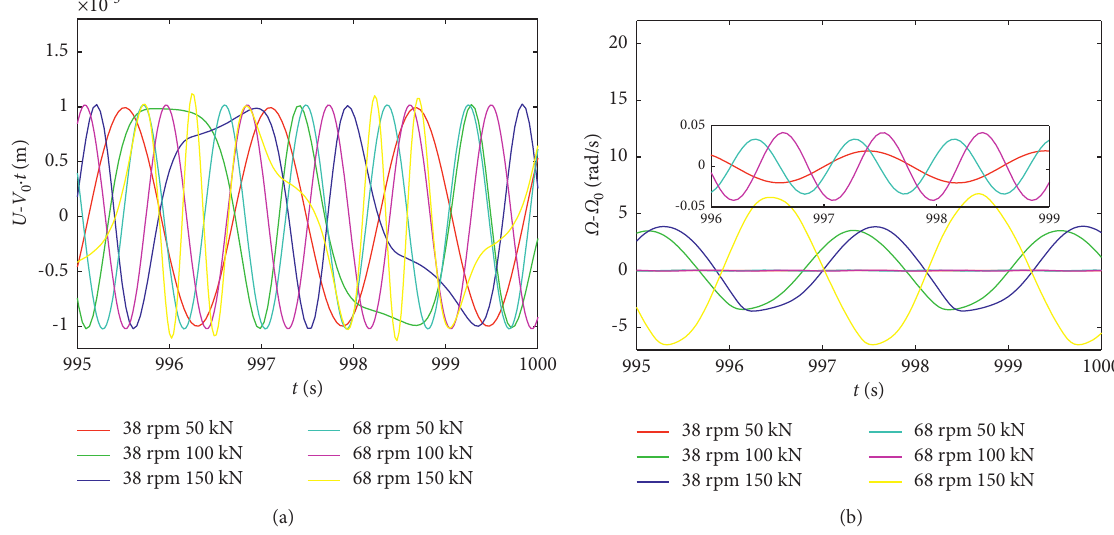
� 50MN/m. (a) Relative c